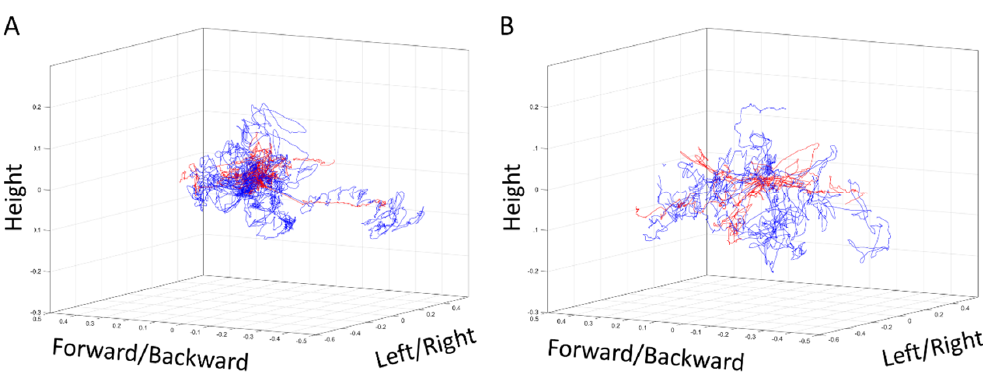
Figure 4. Actual trajectory of the right (blue) and left (red) hands of the participants who had ( A ) a low or ( B ) a high overall proficiency. Overall proficiency was measured by summing the dVSS, BABA, and MC scores.